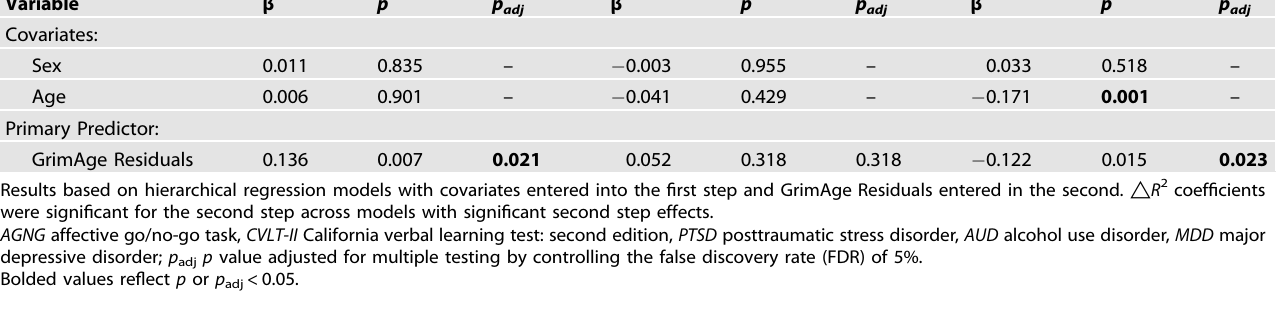
Table 4. Associations between GrimAge residuals and metabolic, immune, and neurology markers. TRACTS